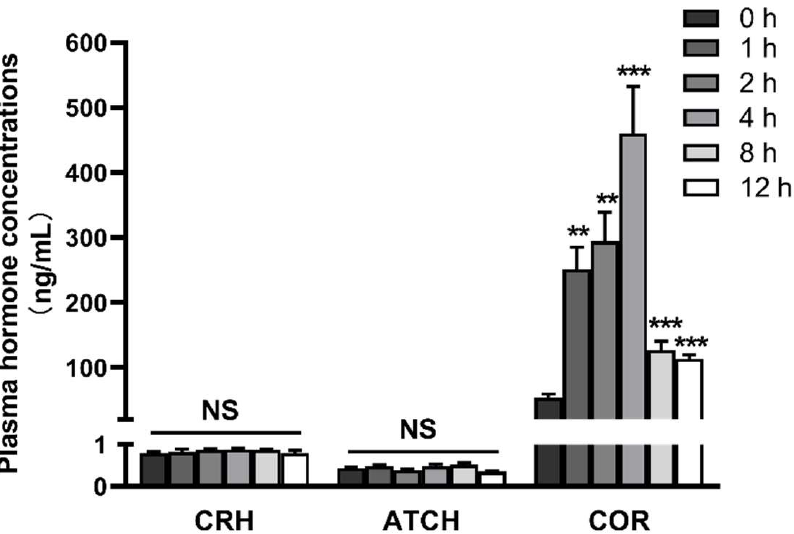
Figure 1. LPS increases the concentrations of cortisol in plasma. The pigs in the control group were sacrificed at 0 h after injection with NaCl solution. The pigs in LPS groups were injected with LPS at 100 µ g/kg BW, and then were sacrificed at 1, 2, 4, 8, or 12 h after LPS challenge. Values are means ± SEM, n = 6. ** p < 0.01, *** p < 0.001, significantly different from the control group (0 h). CRH, corticotropin releasing hormone; ACTH, adrenocorticotrophic hormone.